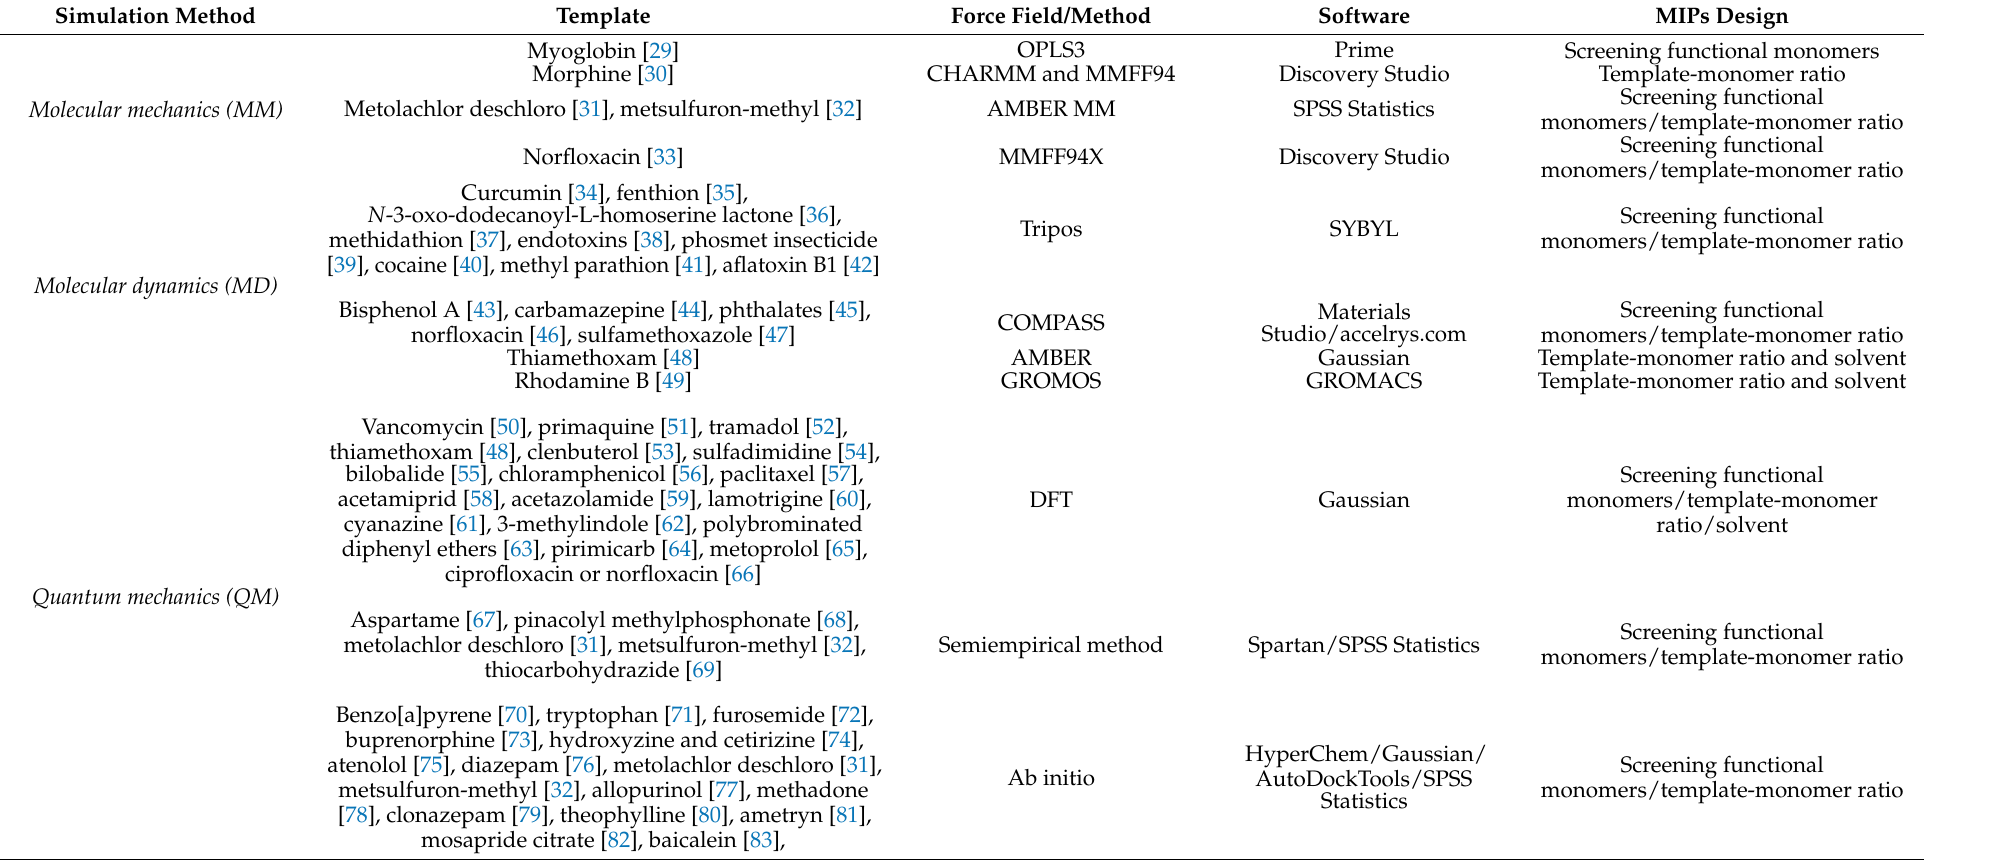
Table 1. Theoretical simulation calculation methods for the design of